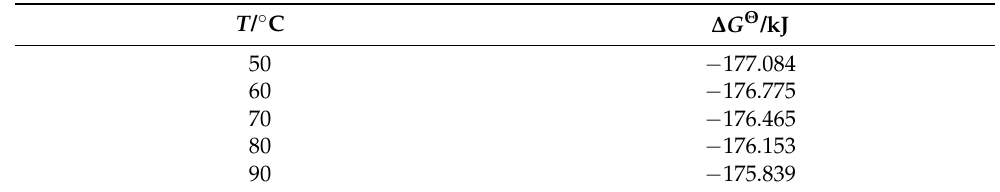
Figure 9. The relationship between reaction temperature and Li + recovery. Table 3. The Gibbs Free Energy Change of the Reaction of Na 3 PO 4 and LiCl at 50–100 ◦ C (by HSC Chemistry 6.0 software (Outokumpu, France)).